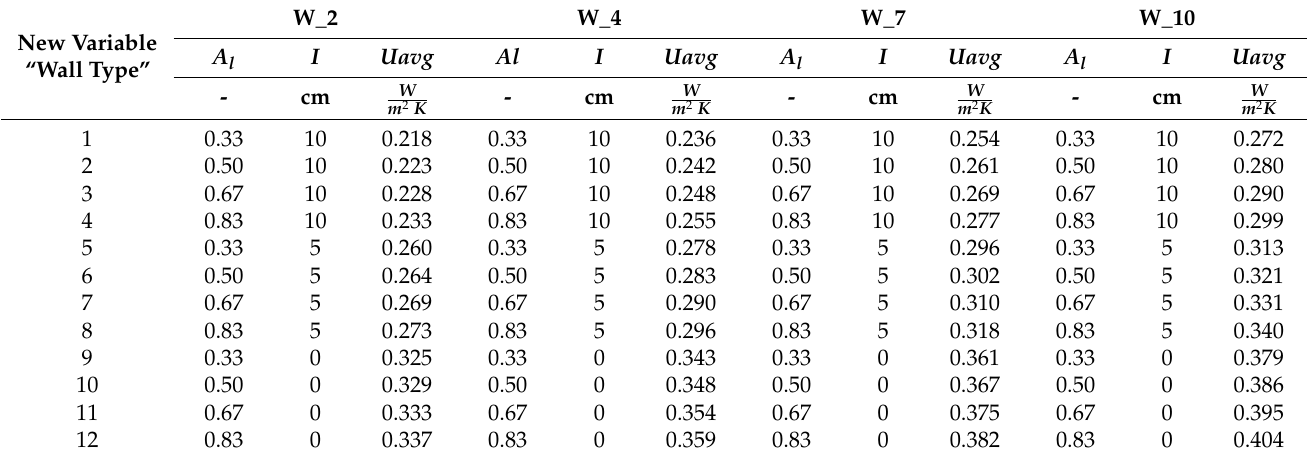
Table 9. The relation between the values of the new decision variable, average thermal insulation of the building, window type, and window area.